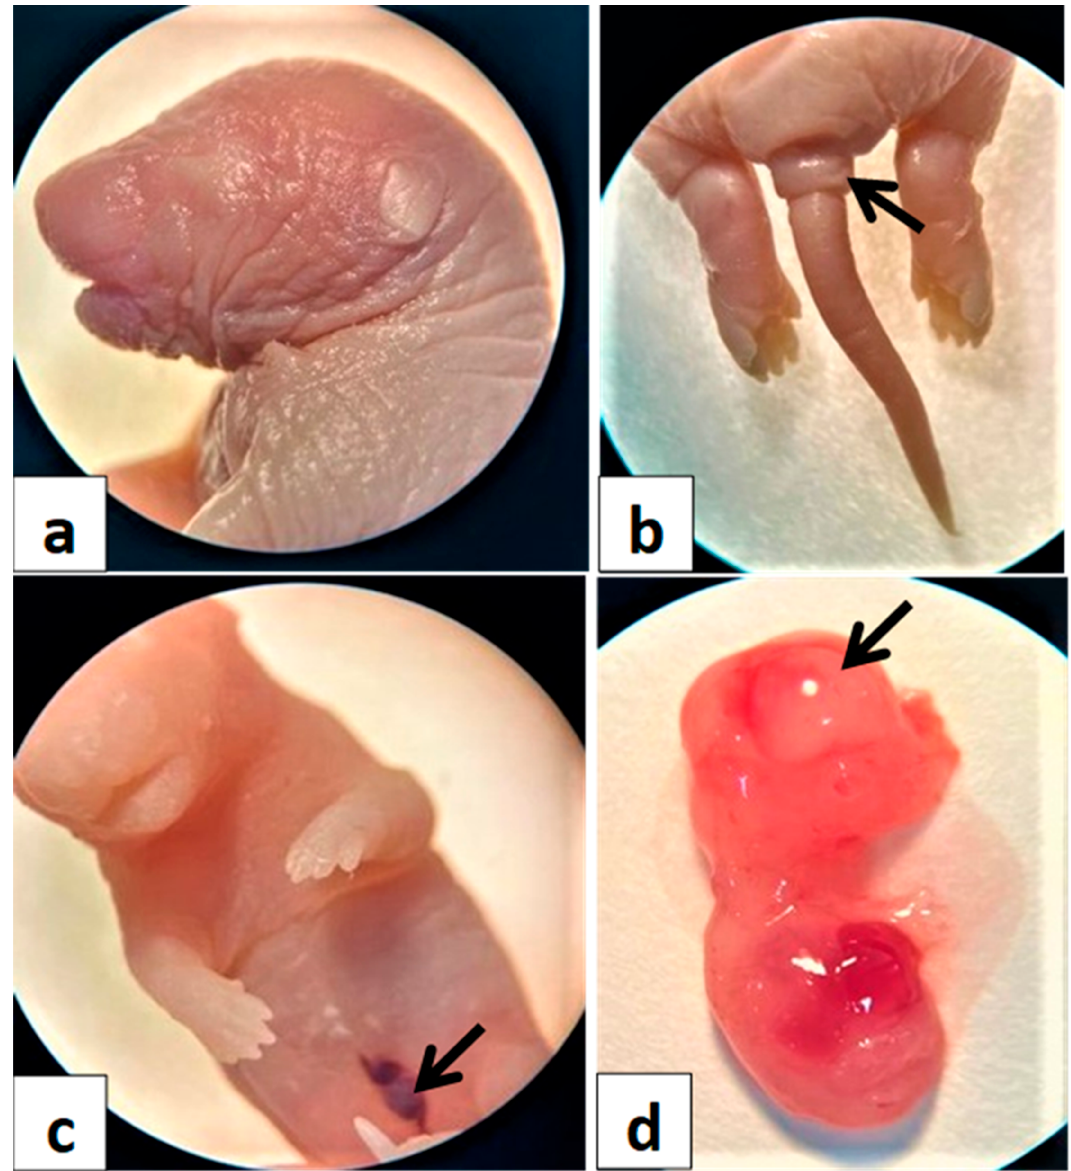
Figure 6. The major external and visceral morphological anomalies of pregnant rats treated with metronidazole during the 0–20th days of the gestational period. ( a ) control group, ( b ) show tail defects (arrow), ( c ) show visceral hernia (arrow), and ( d ) indicate exencephaly (arrow). Table 2. Effect of metronidazole on lipid profile in pregnant albino rats. Lipid Index